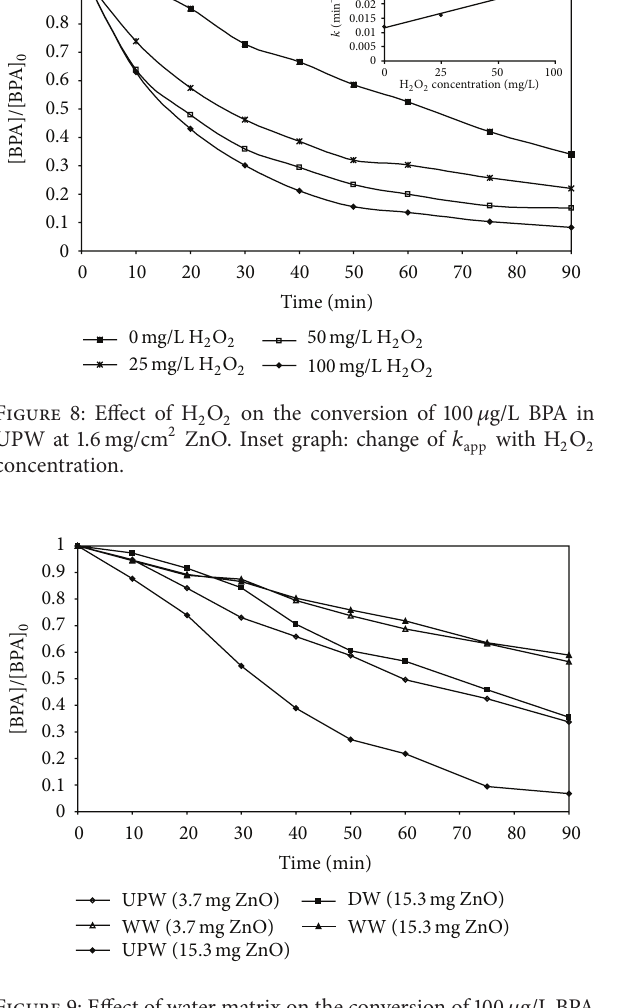
Figure 9: Effect of water matrix on the conversion of 100 𝜇 g/L BPA at two ZnO